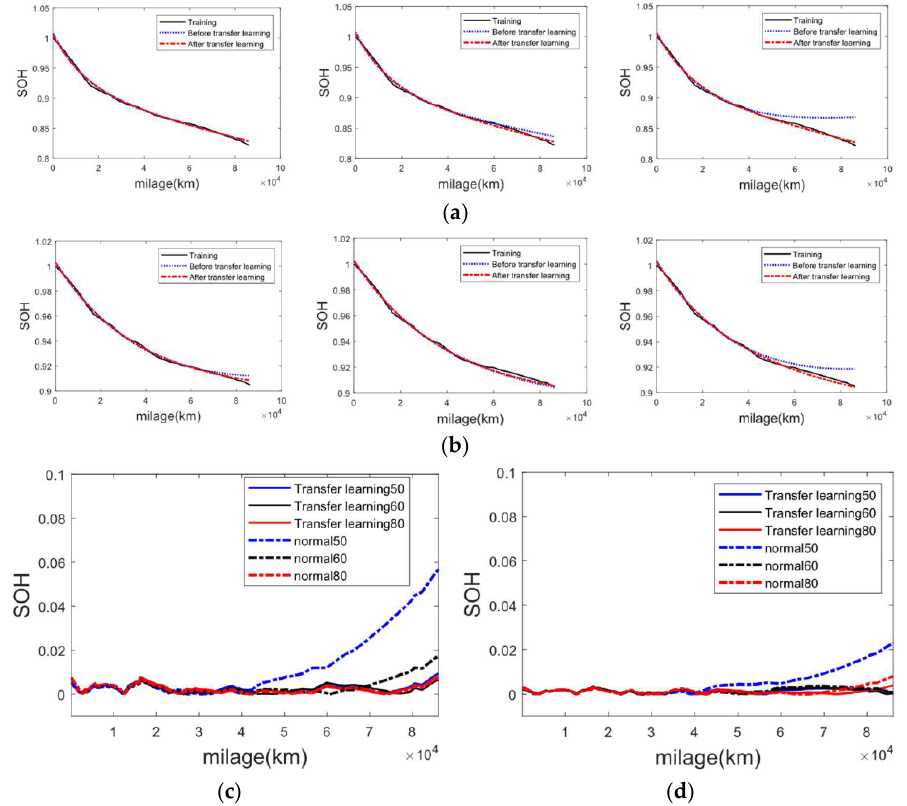
Figure 7. Battery pack SOH prediction results, ( a ) training set using 80, 60 and 50 SOH points with charging data, ( b ) training set using 80, 60 and 50 SOH points with discharging data, ( c ) SOH prediction error with charging data and ( d ) discharging data.